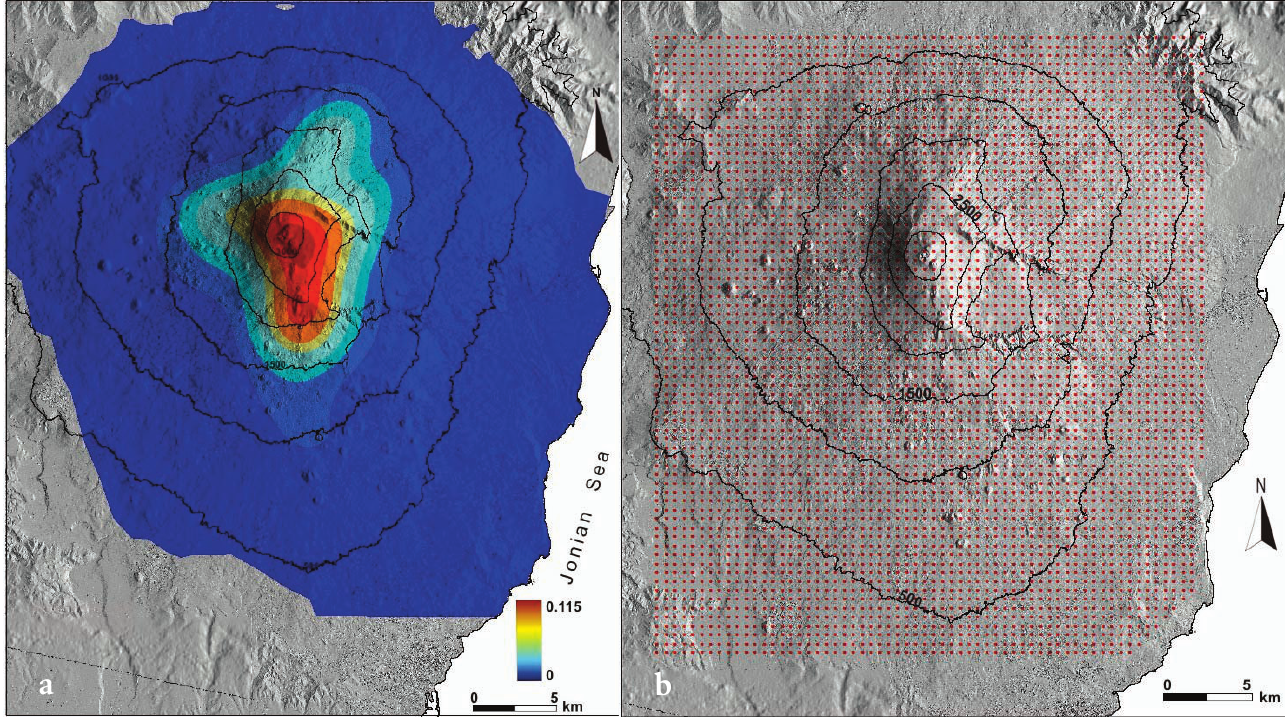
Figure 3. (a) Characterization of new vents forming in the study region, with the different probabilities of activation, considered in this study. (b) Grid of the hypothetical vents defined as the source for the simulations to be carried out in this